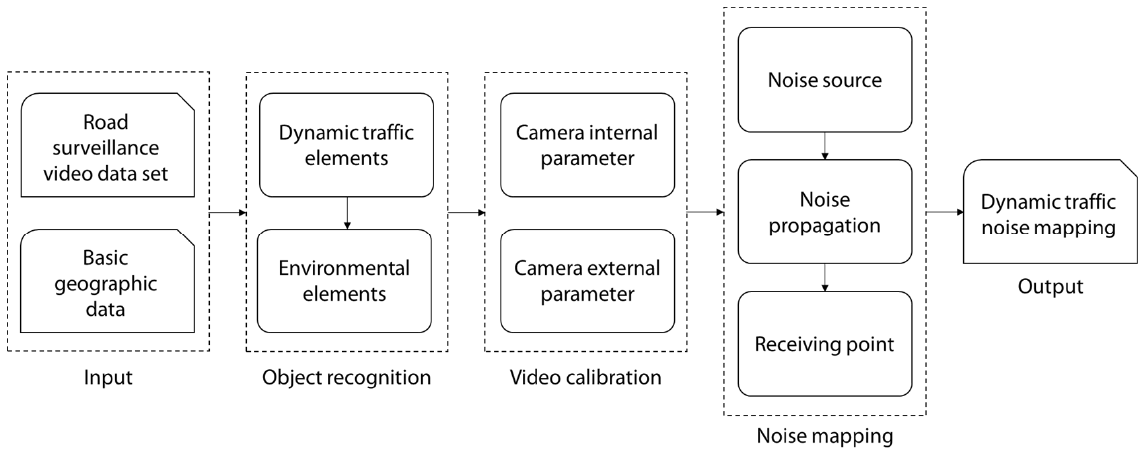
Figure 1. Overview of the dynamic traffic noise mapping model based on road surveillance video